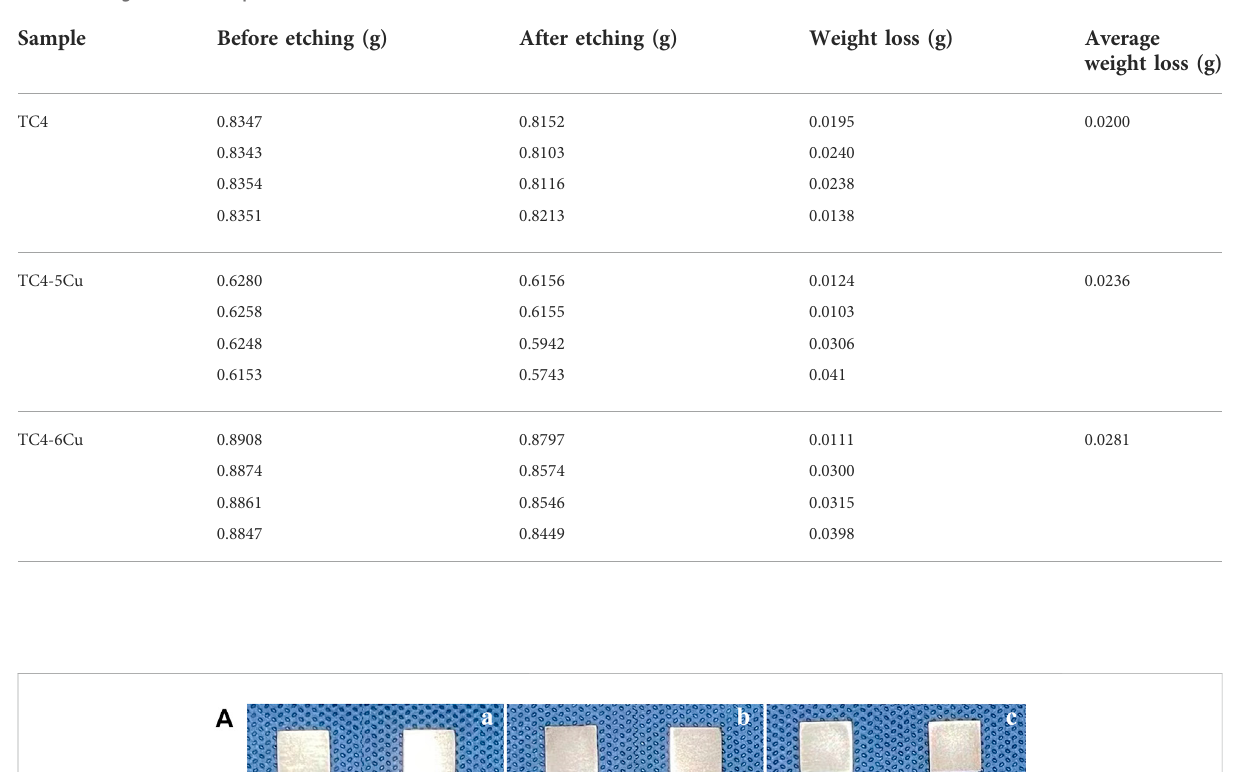
TABLE 1 Weight of the samples.